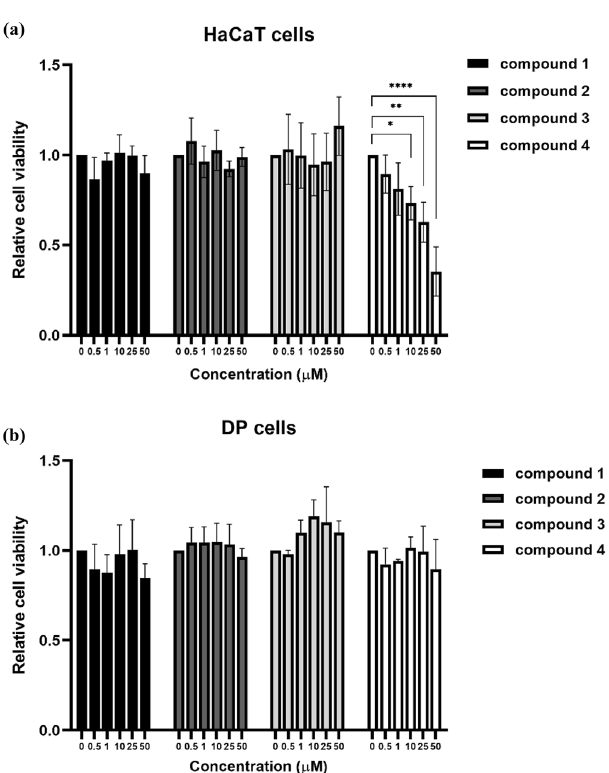
Figure 4. Cytotoxicity of caffeic acid ( 1 ) and its amide derivatives (compounds 2− 4) against ( a ) HaCaT and ( b ) DP cells. The N -[3,5-bis(trifluoromethyl)phenyl]-containing amide 4 showed cytotoxicity at IC 50 of 29.99 ± 8.69 µM against HaCaTs. The data of three independent experiments were represented as means ± standard deviation (SD). The viability of the compound-treated cells was compared to that of the untreated controls; * p < 0.05, ** p < 0.001, and **** p <